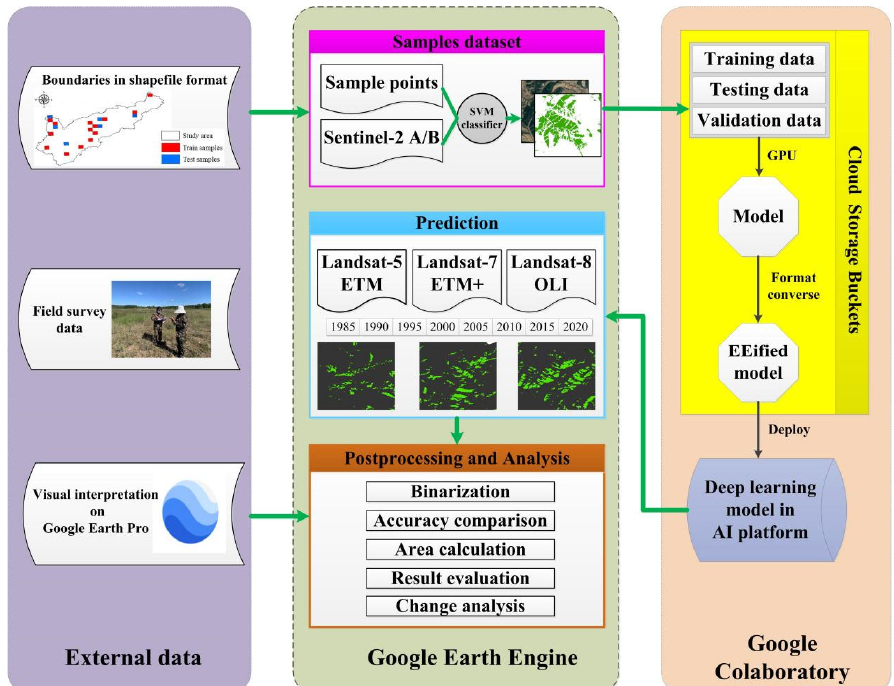
Figure 6. Workflow of this study.